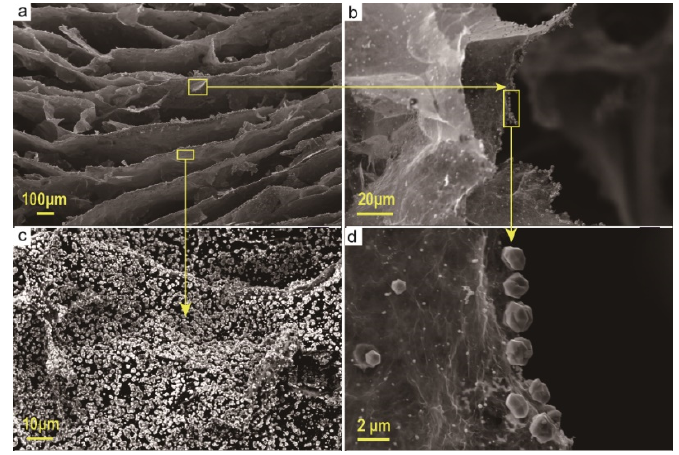
Figure 2. SEM image of the pore wall of the graphene aerogel attached silver ( a ) a cross-section of the aerogel; ( b ) the graphene sheets on the pore wall of the aerogel; ( c ) the silver particles attached to the aerogel pore wall; ( d ) the silver particles attached to the edge of the graphene sheet of the aerogel pore wall.